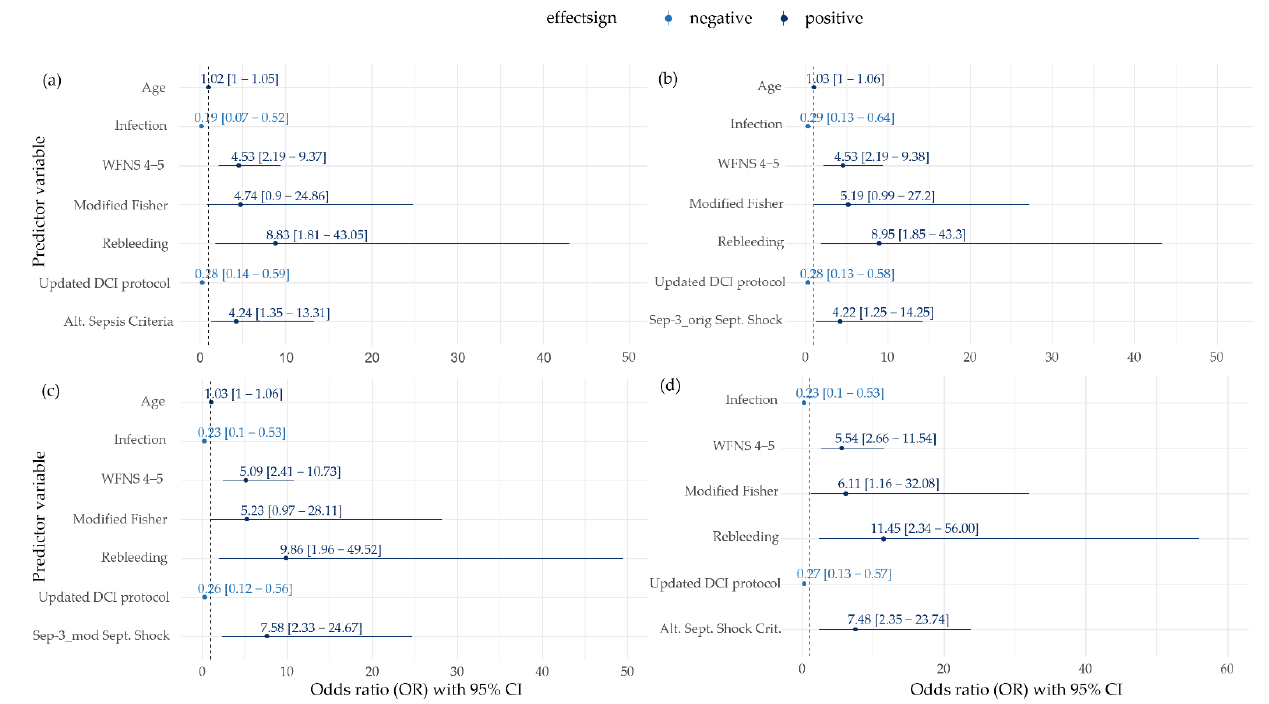
Figure 3. Multivariate logistic regression model-based odds ratios with 95%CI for in-hospital death at discharge. Different criteria for diagnosis of sepsis (( a ) alternative sepsis criteria; ( b ) septic shock Sepsis-3_orig; ( c ) septic shock Sepsis-3_mod; ( d ) alternative septic shock criteria) were added one